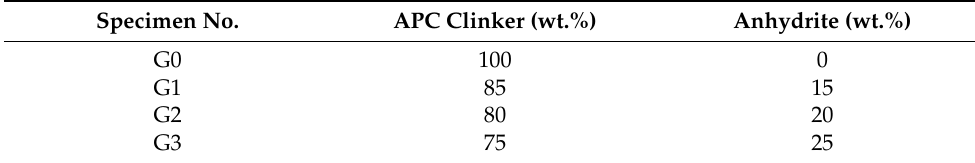
Table 1. The mix ratios of APC and anhydrite. Specimen